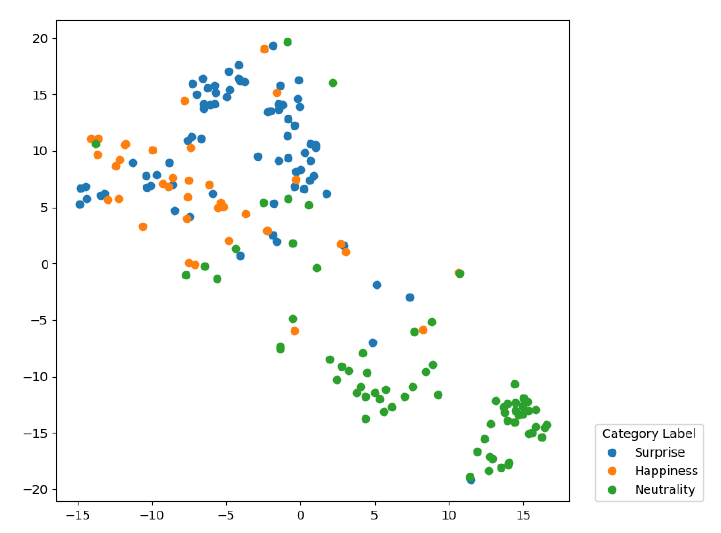
Figure 10. Visualization of distributions of deep emotion features of the student model.